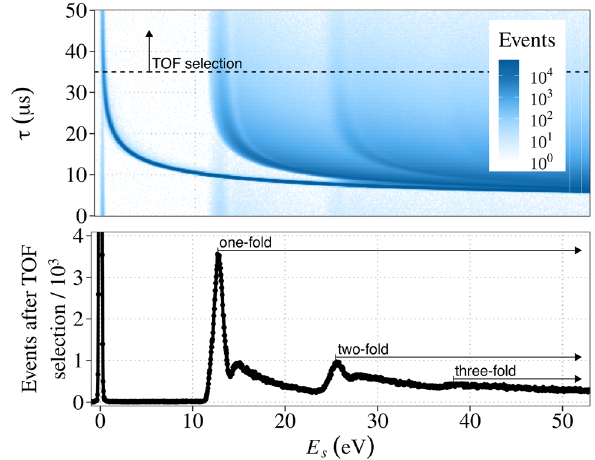
Fig. 4 The differential measurements of the time of flight τ (top) and its one-dimensional projection on the electron surplus energy E s axis (bottom) at 86% of nominal column density. The dashed line marks the lower boundary of the TOF selection at τ cut = 35 μ s. The bottom panel shows all events in the TOF